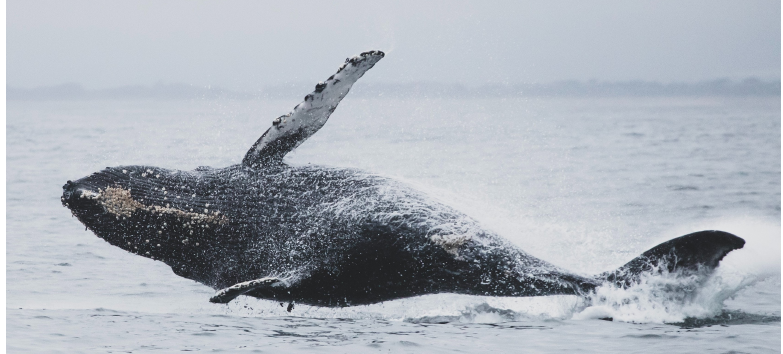
Figure 1. Humpback whale, with tubercles at their leading edge flippers. Picture by Andre Estevez from Pexels